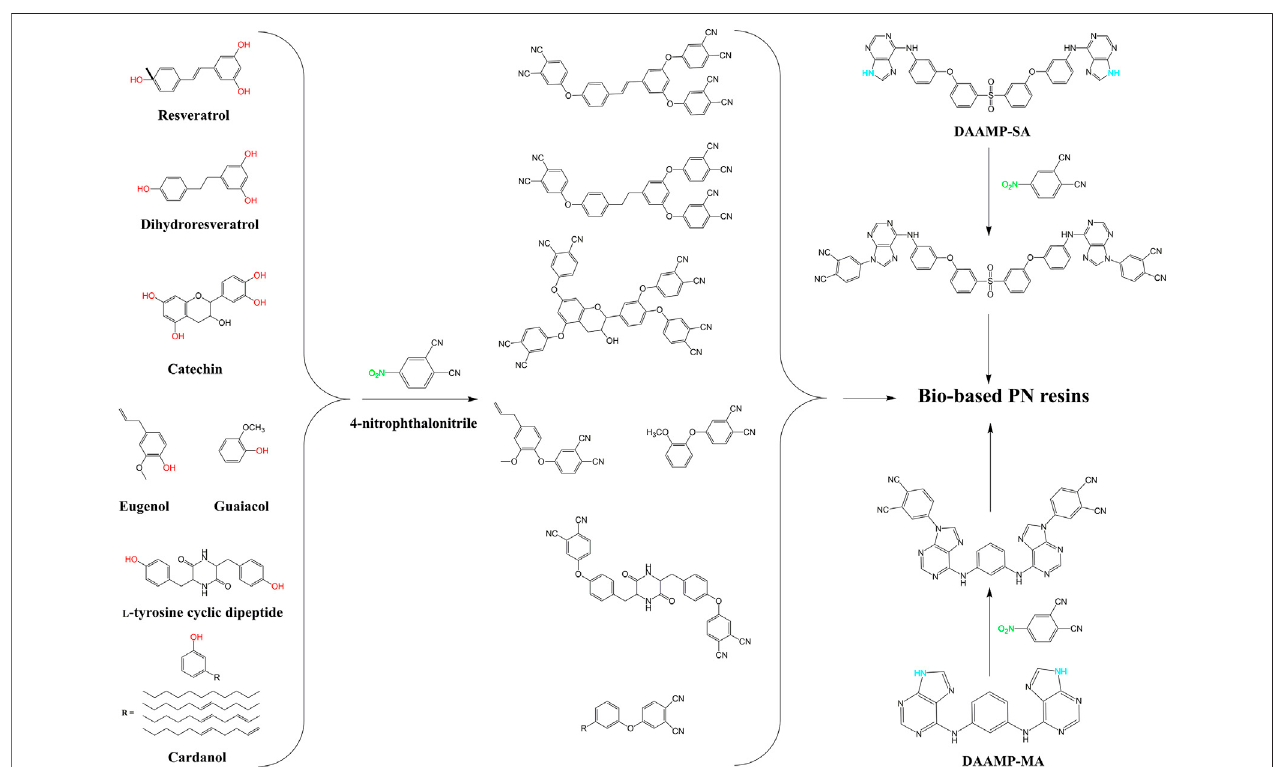
FIGURE 2 | Synthetic routes of bio-based phthalonitrile